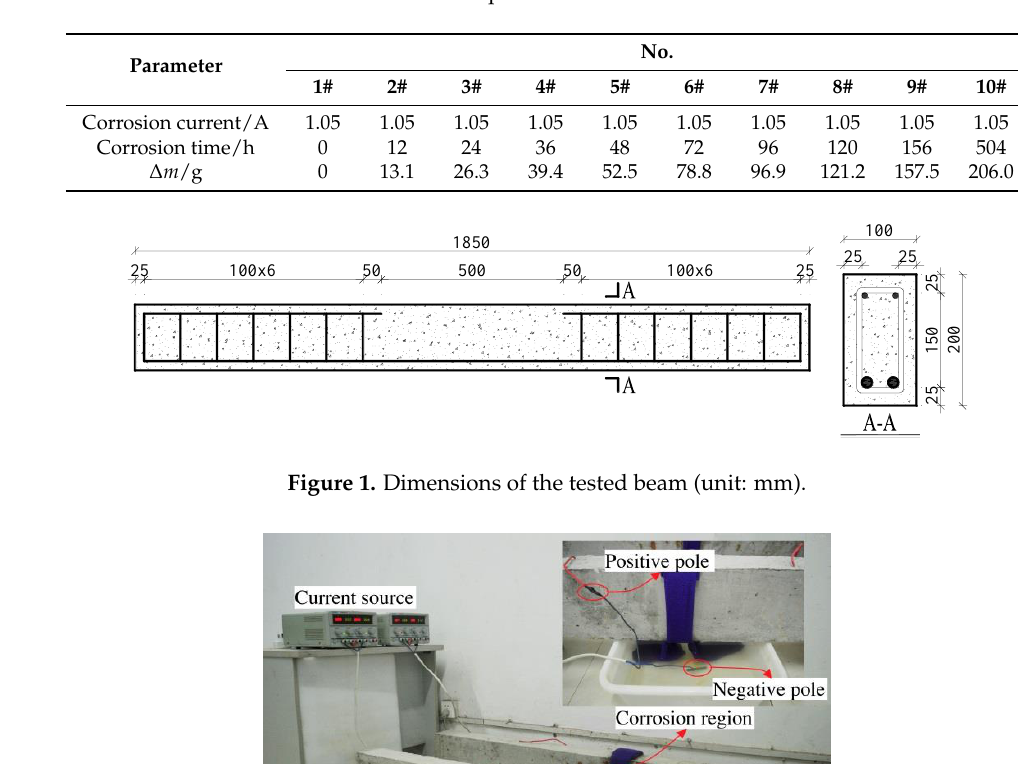
Table 2. Corrosion parameters of all tested beams.